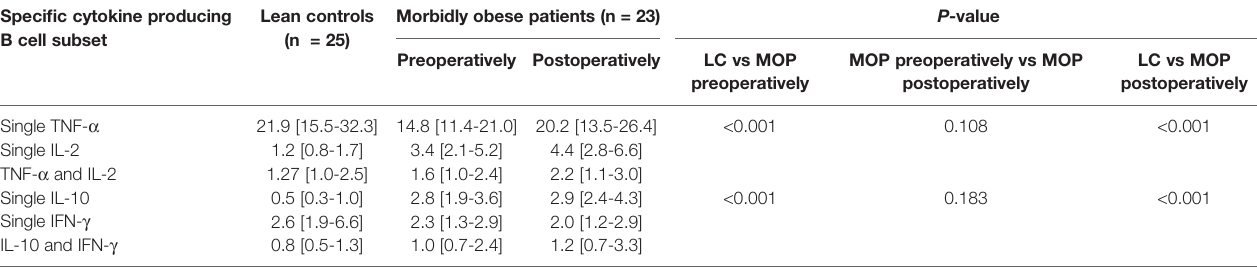
TABLE 3 | Maximal cytokine producing capacity by B